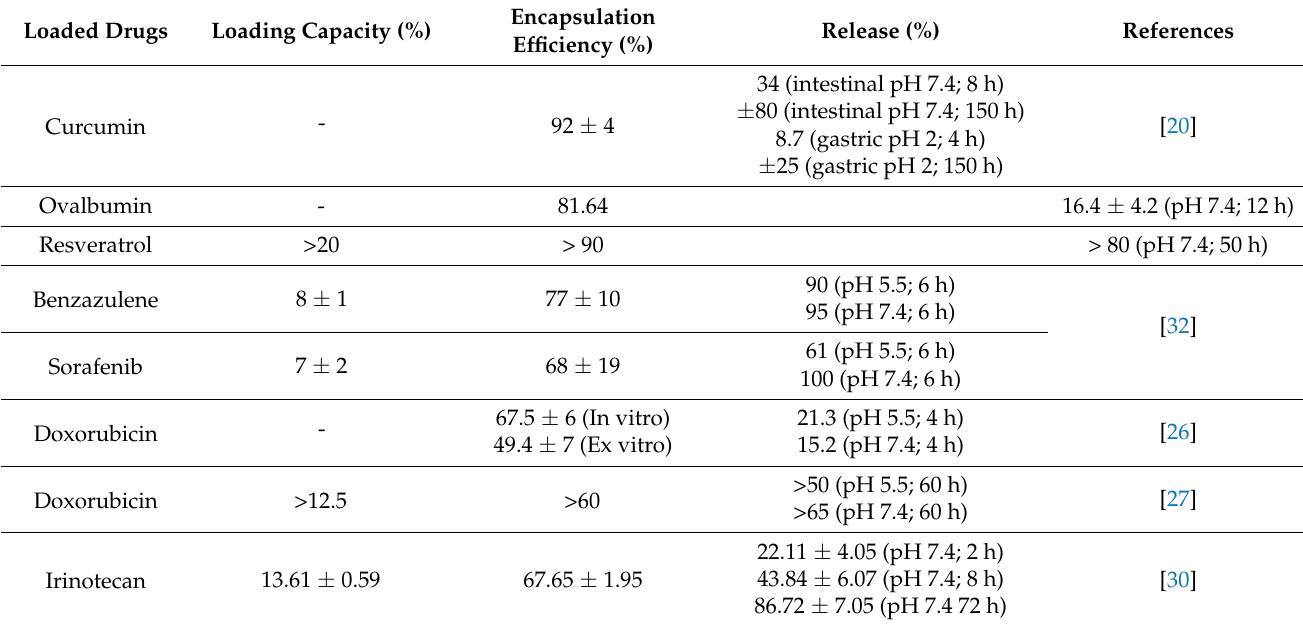
Table 3. The capability of LNPs as a drug carrier for several types of